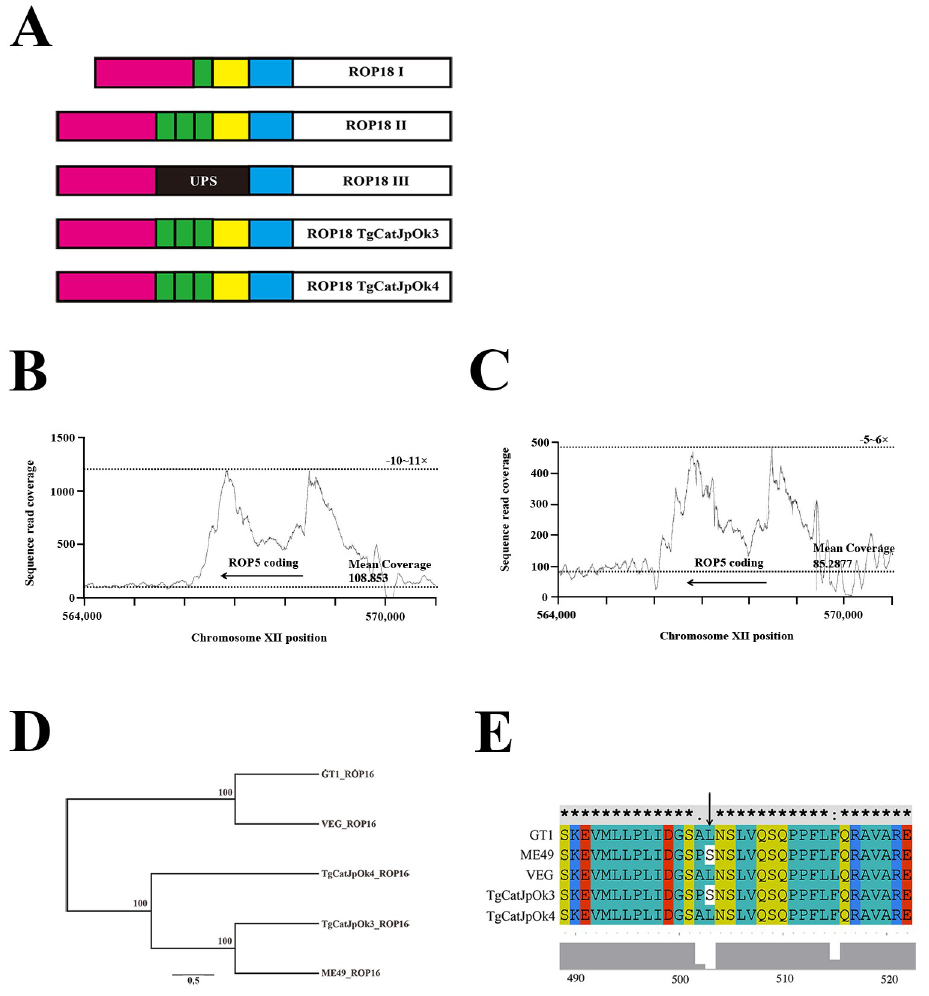
Fig 4. Comparison of TgCatJpOk4 genes responsible for virulence of T . gondii with those in 3 archetypical strains. (A) Schematic of the ROP18 gene sequence. UPS; upstream segment (B,C) Copy number of ROP5. The copy number is indicated by the read coverage of TgCatJpOk3 (B) and TgCatJpOk4 (C) around the ROP5 coding region on the ME49 genome (reference genome). Arrows show the coding region of ROP5 on the chromosome XII. Mean coverages indicate the average depth in TGME49_chrXII:564000–566000, whose position was adjacent to the ROP5 coding region. (D) Phylogenetic analysis of the ROP16 amino acid sequence of TgCatJpOk3, TgCatJpOk4 and type I (GT1), type II (ME49), and type III (VEG) strains. (E) Alignment of amino acid sequences from 489 to 522 of ROP16. The arrow shows the leucine residue that is required for activation of STAT3 [23].